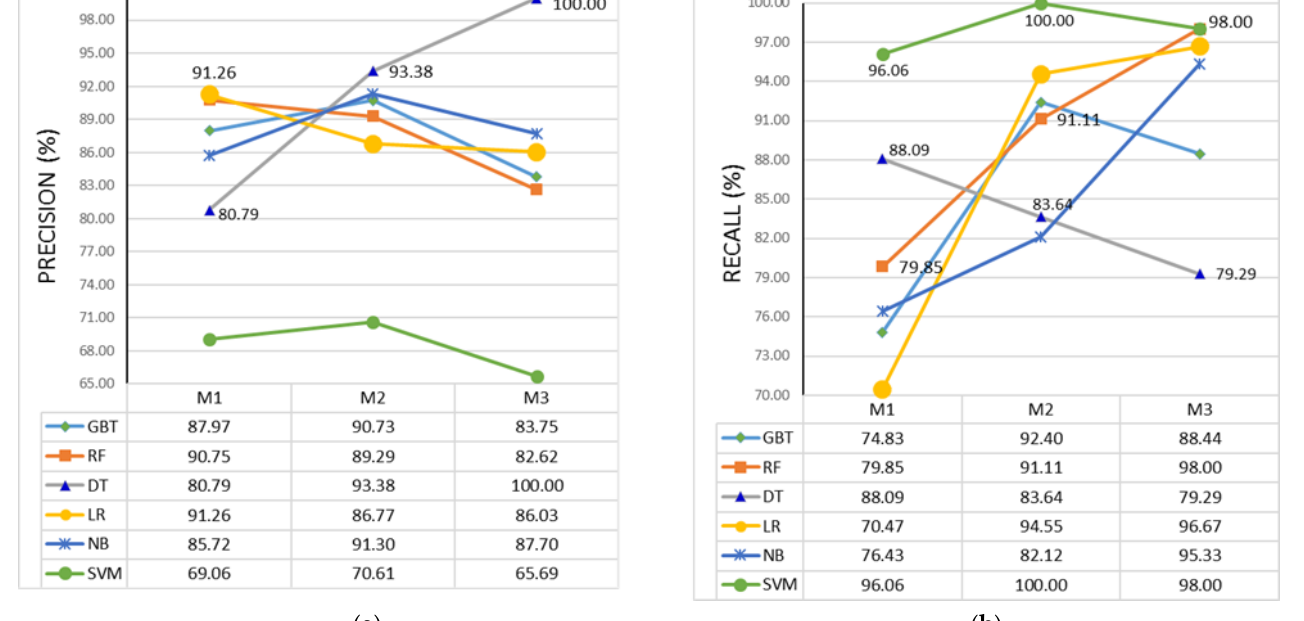
Figure 2. Classification algorithms metrics: ( a ) Precision metric; ( b ) Recall metric.